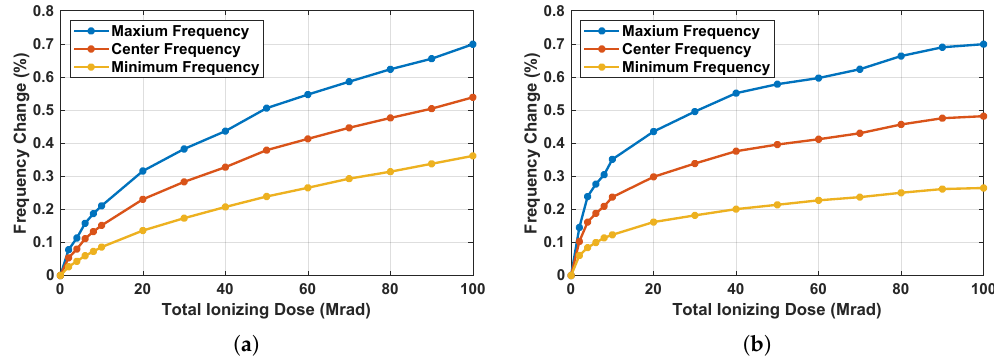
Figure 8. Percentage frequency variations of ( a ) PQVCO and ( b ) SQVCO measured with respect to the TID of the order of 100 Mrad (SiO 2 ).